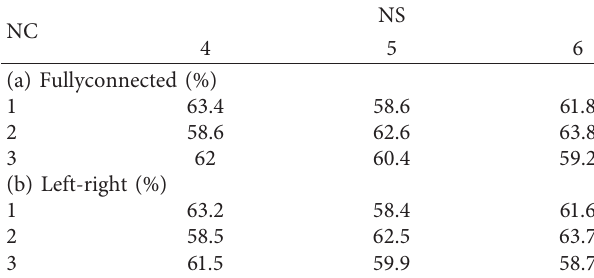
Table 3: Automatic classification results under different